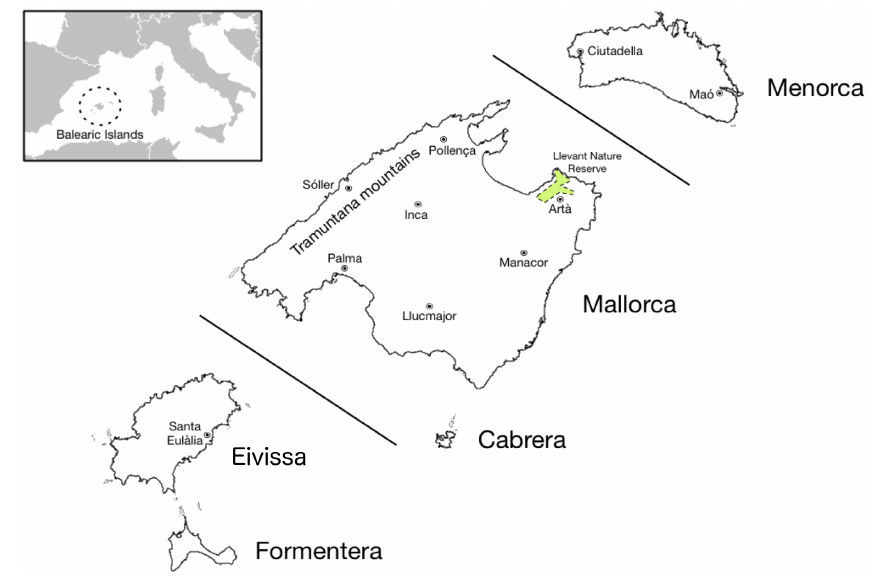
Figure 1. The Balearic Islands. Locations mentioned in the text are